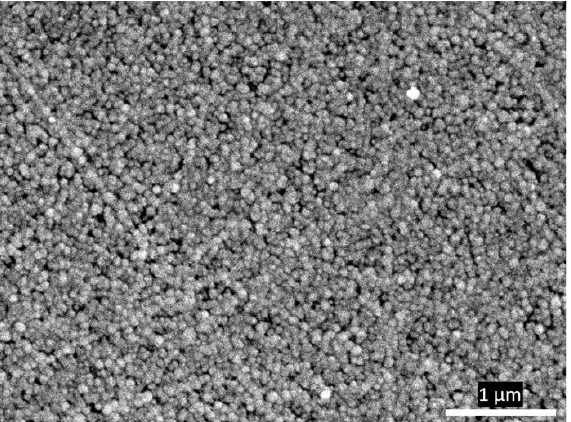
Figure 2. SEM image of the gold film deposited on a silicon prism. Magnification was ×25,000.